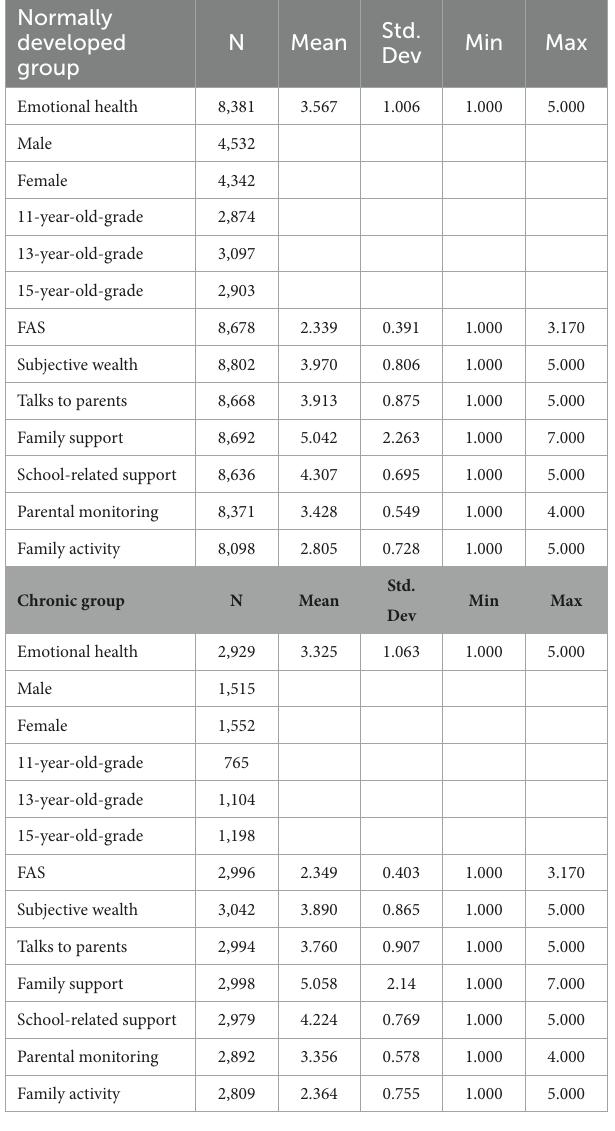
TABLE 1 The descriptive statistics of sample